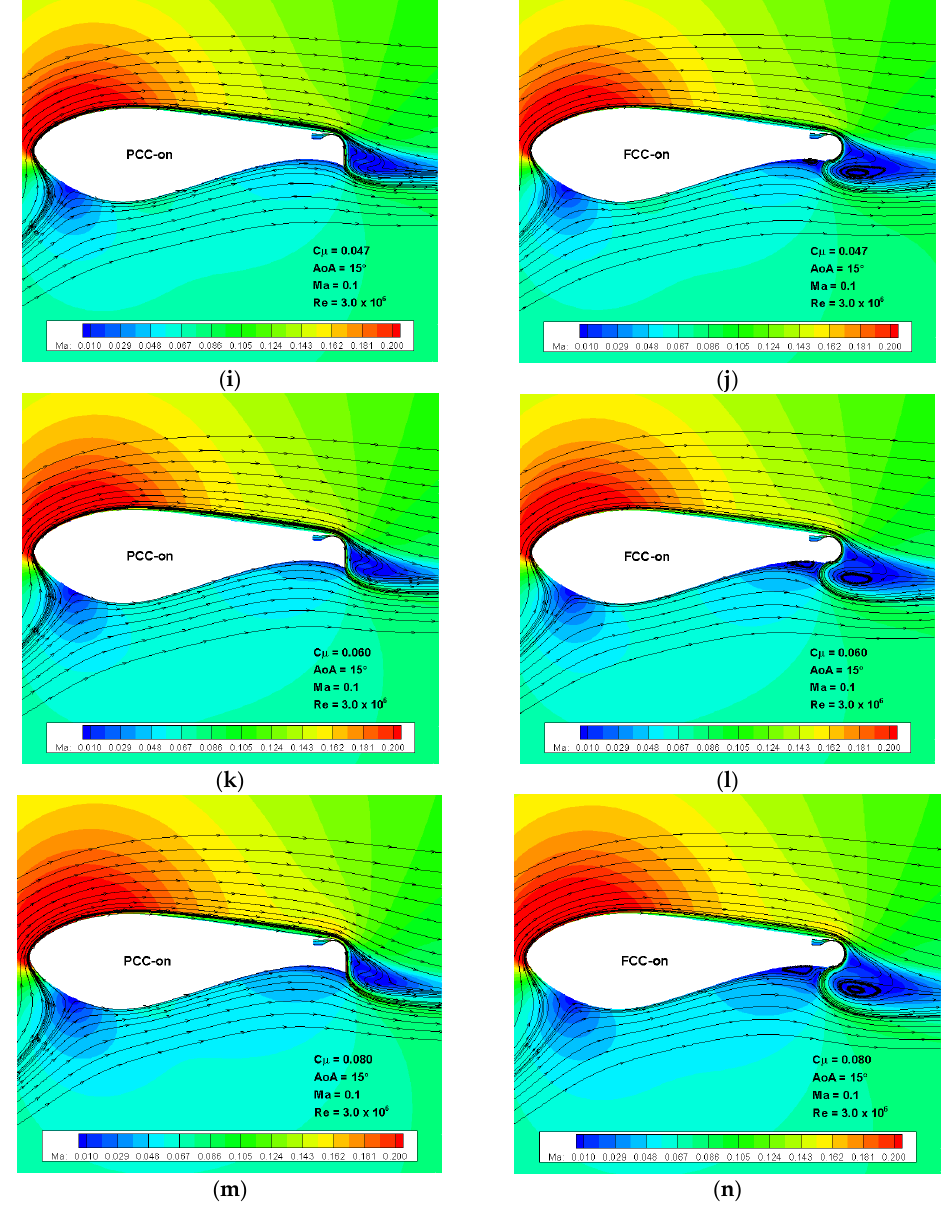
Figure 14. Flow fields of PCC-on and FCC-on at different jet momentum coefficient levels: ( a ) PCC-on at C μ = 0.010; ( b ) FCC-on at C μ = 0.010; ( c ) PCC-on at C μ = 0.015; ( d ) FCC-on at C μ = 0.015; ( e ) PCC-on at C μ = 0.030; ( f ) FCC-on at C μ = 0.030; ( g ) PCC-on at C μ = 0.038; ( h ) FCC-on at C μ = 0.038; ( i ) PCC-on at C μ = 0.047; ( j ) FCC-on at C μ = 0.047; ( k ) PCC-on at C μ = 0.060; ( l ) FCC-on at C μ = 0.060; ( m ) PCC-on at C μ = 0.080; ( n ) FCC-on at C μ = 0.080.